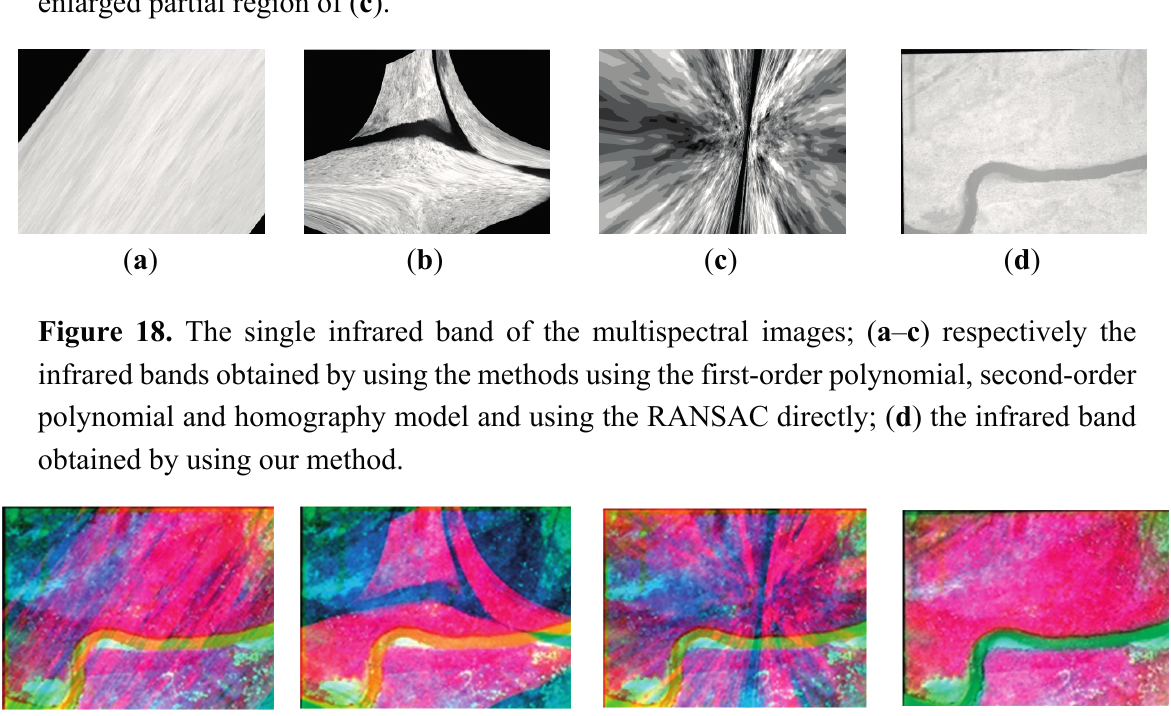
Figure 17. The true-color composite (red, green, blue); ( a ) the unregistered multispectral image; ( b ) the enlarged partial region of ( a ); ( c ) the registered multispectral image; ( d ) the enlarged partial region of ( c ).